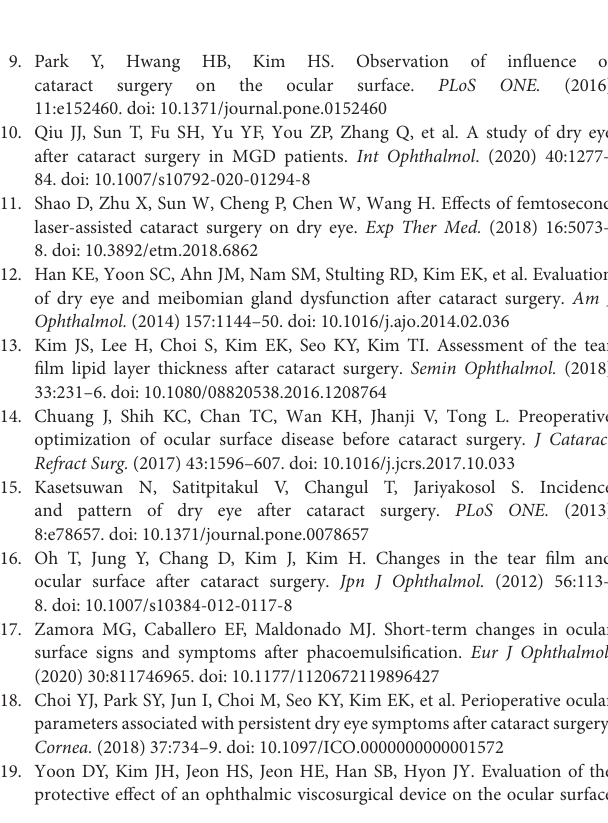
Supplementary Table 1 | Sensitivity analyses on dry eye questionnaires by excluding one study at a time. Supplementary Table 2 | Sensitivity analyses on tear break-up time by excluding one study at a time. Supplementary Table 3 | Sensitivity analyses on corneal fluorescein staining by excluding one study at a time. Supplementary Table 4 | Sensitivity analyses on Schirmer I test by excluding one study at a